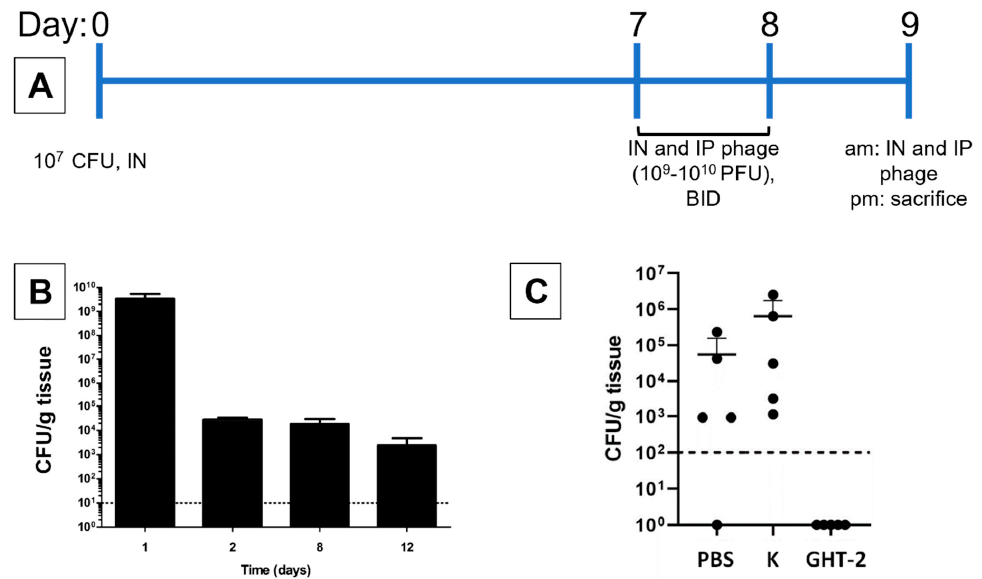
Figure 2. A Gp102 loss-of-function mutation was required for phage K to clear S. aureus NRS384 from the mouse upper respiratory tract in a chronic colonization model. ( A ) Timeline of the infection model. ( B ) Bacterial burden in the mouse upper respiratory tract when untreated. ( C ) Effect of treatment with wild-type phage K, the GHT-2 mutant (gp102 RBS is mutated), or the vehicle control (PBS, phosphate-buffered saline). Dotted horizontal lines in panels B and C reflect 10 CFU/g and 100 CFU/g detection limits, respectively.